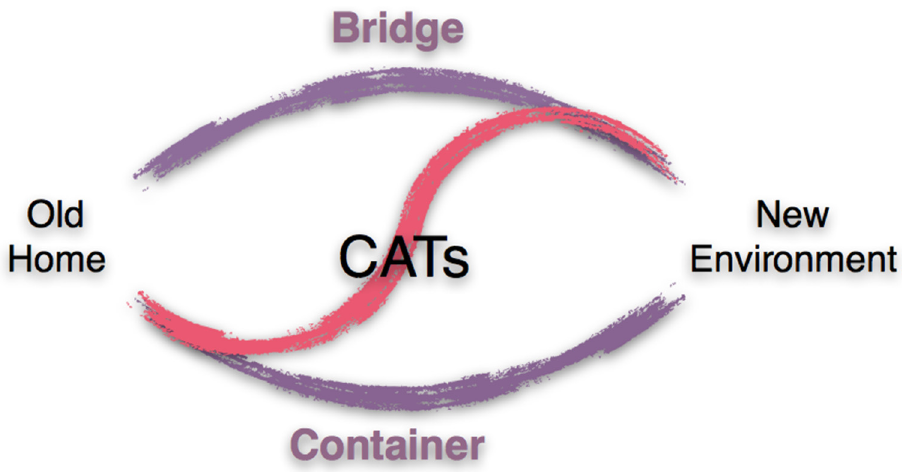
Figure 2. Creative Arts Therapies (CATs) as Container and Bridge.